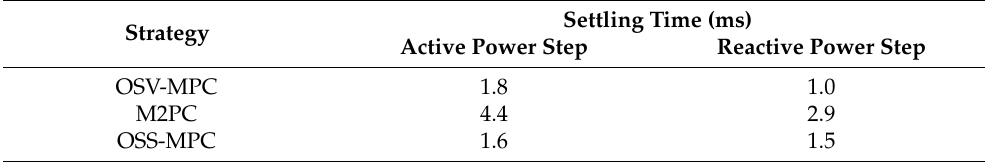
Table 5. Transient experimental